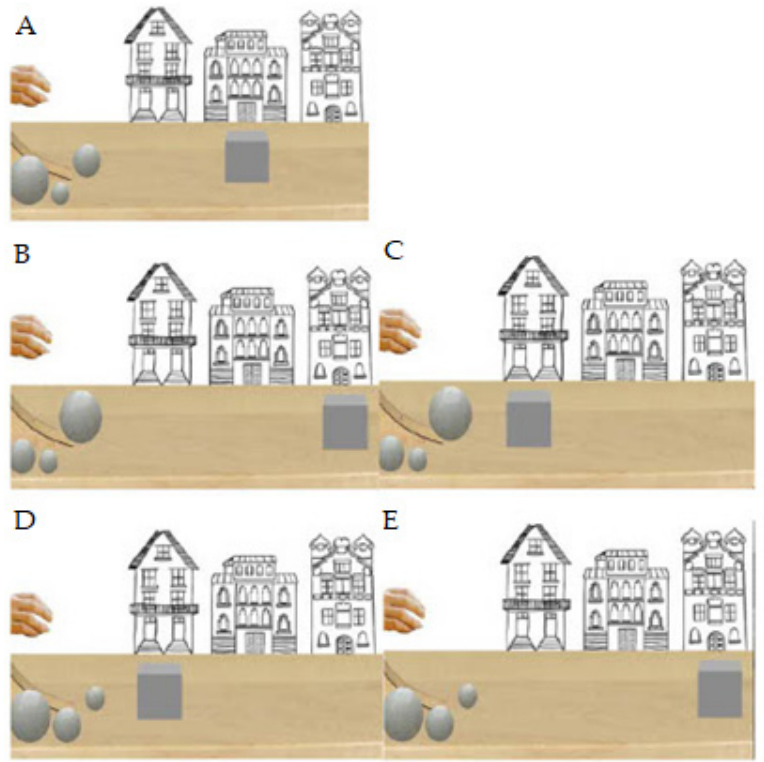
Figure 1. ( A ) Habituation event, ( B ) Large ball congruent, ( C ) Large ball incongruent, Bottom: ( D ) Small ball congruent, ( E ) Small ball incongruent event outcomes.